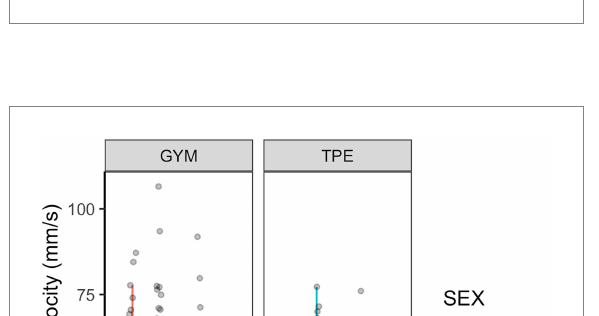
FIGURE 5 Anterior – posterior sway velocity for males and females in the GYM and TPE groups.